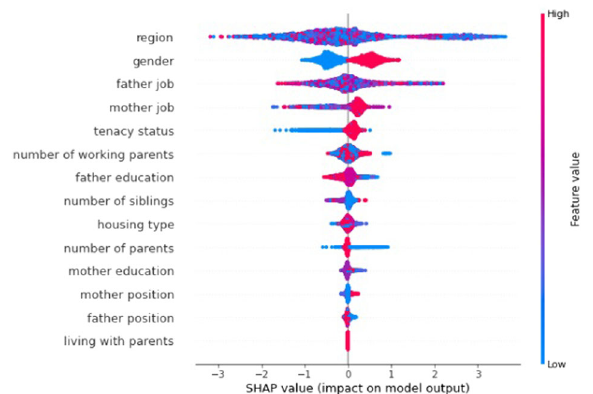
Fig. 2 LightGBM SHAP summary plot. Note: (1) The order from the top vertically indicates the importance of the variable. (2) Red color indicates a high value and blue color indicates a low value of the variable. (3) The horizontal axis denotes the impact of the value of the variable on the output. (4) The density achieved by the dots indicates their